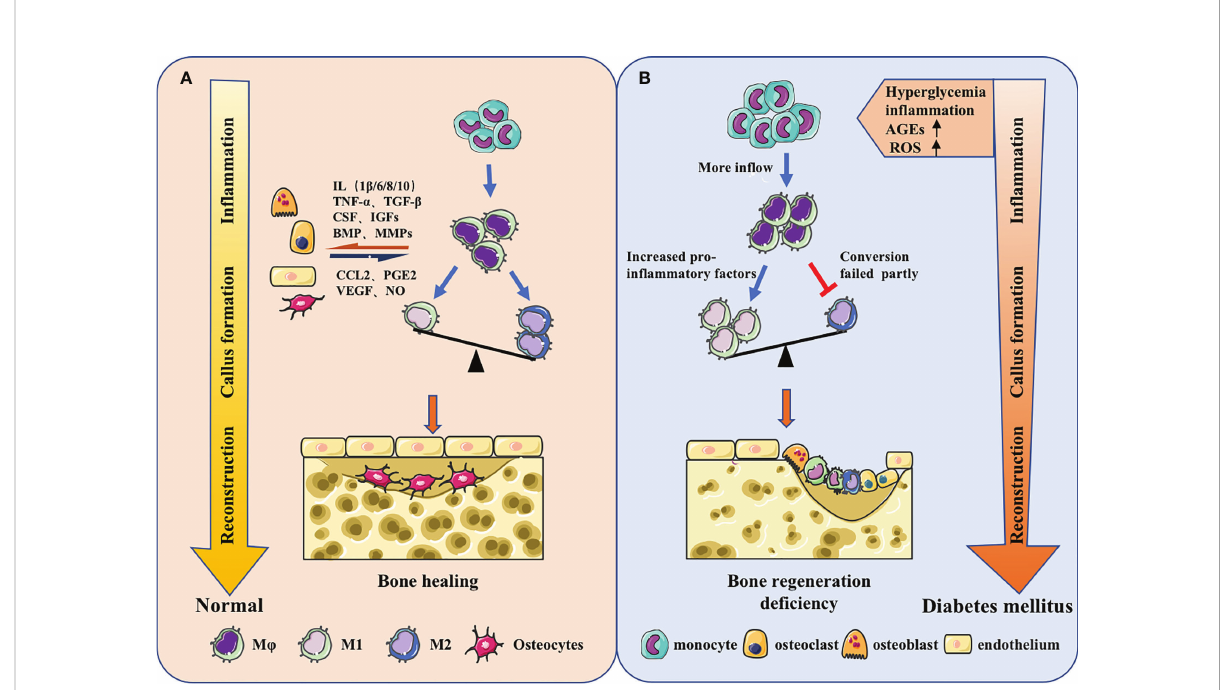
FIGURE 2 Macrophages in different bone regeneration microenvironments. (A) Macrophages will make adaptations in the local microenvironment. From the in fl ammatory stage, callus formation stage to the reconstruction stage, the predominance of pro-in fl ammatory M1 macrophages will gradually shift to the pro-repair M2 macrophages. Meanwhile, macrophages have coordinated cross-talk with other osteoblast-related cells, jointly regulating bone regeneration. (B) The origin of macrophages could change and the function could be impaired under the stimulation of high glucose, in fl ammation, AGEs, ROS and other metabolites in diabetes. The increase of monocyte-derived macrophages in the in fl ammatory phas and the failure of macrophage polarization during callus formation and bone remodeling stage could ultimately lead to insuf fi cient